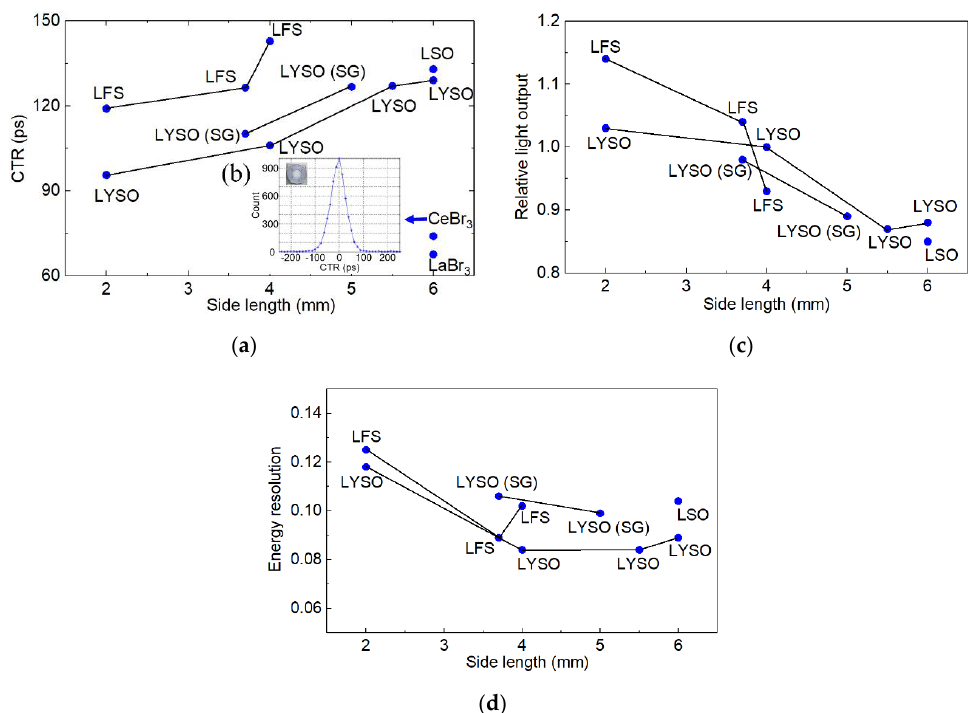
Figure 9. ( a ) CTR values, ( b ) time spectrum of the 6 mm CeBr 3 cube; ( c ) relative light outputs and ( d ) energy resolutions of cubic crystal. Crystals 2020 , 10 , x FOR PEER REVIEW